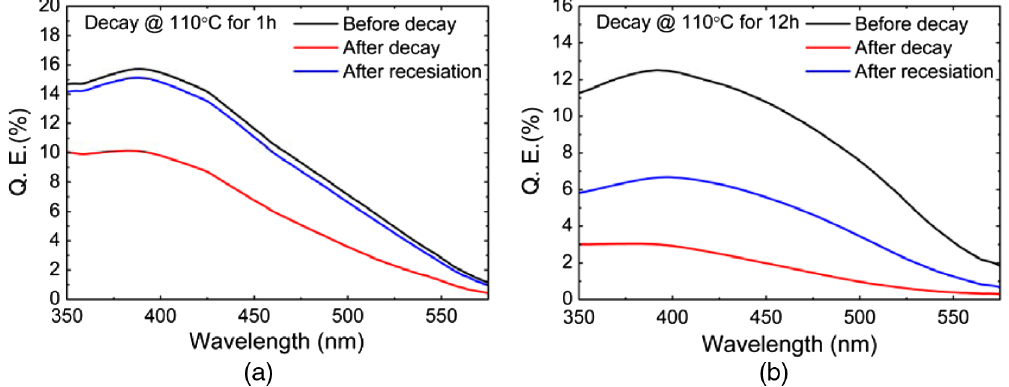
FIG. 6. Spectral response comparisons of the K-Cs-Sb photocathodes decayed at 110 °C for 1 hour (a) and 12 hours (b).